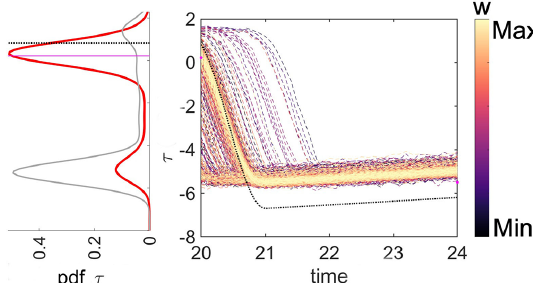
Figure 5. Shear-stress evolution with weight distribution at time t = 20. The color of the lines represents the value of the weight, which is a function of the distance between the prior shear-stress estimate and the observation. The red line represents the posterior pdf, the gray line represents the prior pdf, the magenta line shows where the observation stands and the black line is the true